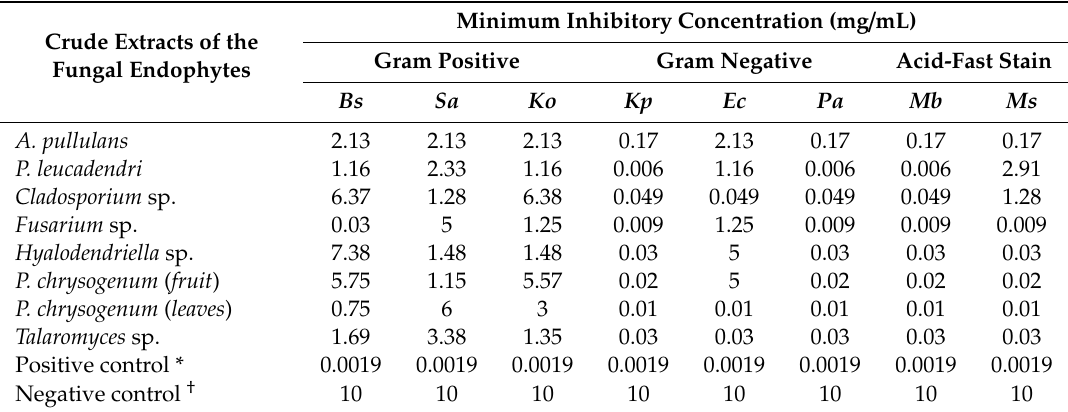
Table 5. Minimum inhibitory concentrating assay of the fungal secondary